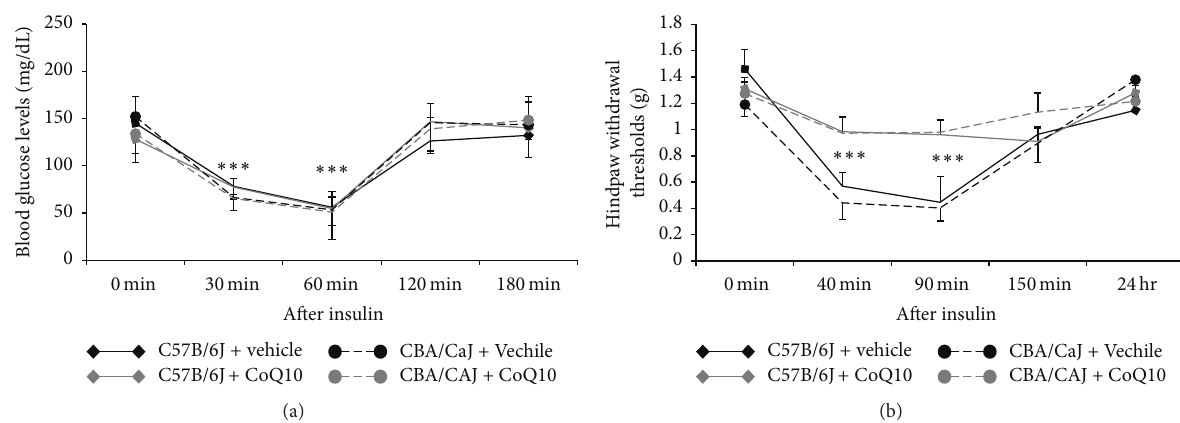
Figure 3: CoQ10 prevented the development of mechanical hypersensitivity. (a) CoQ10 had no effect on blood glucose levels. (b) In both strains tested, withdrawal thresholds remained stable with no significant changes in the group pretreated with CoQ10 compared to the prevehicle-injected group; ∗ ∗ ∗ represents 𝑝 < 0.001 with ANOVA test.